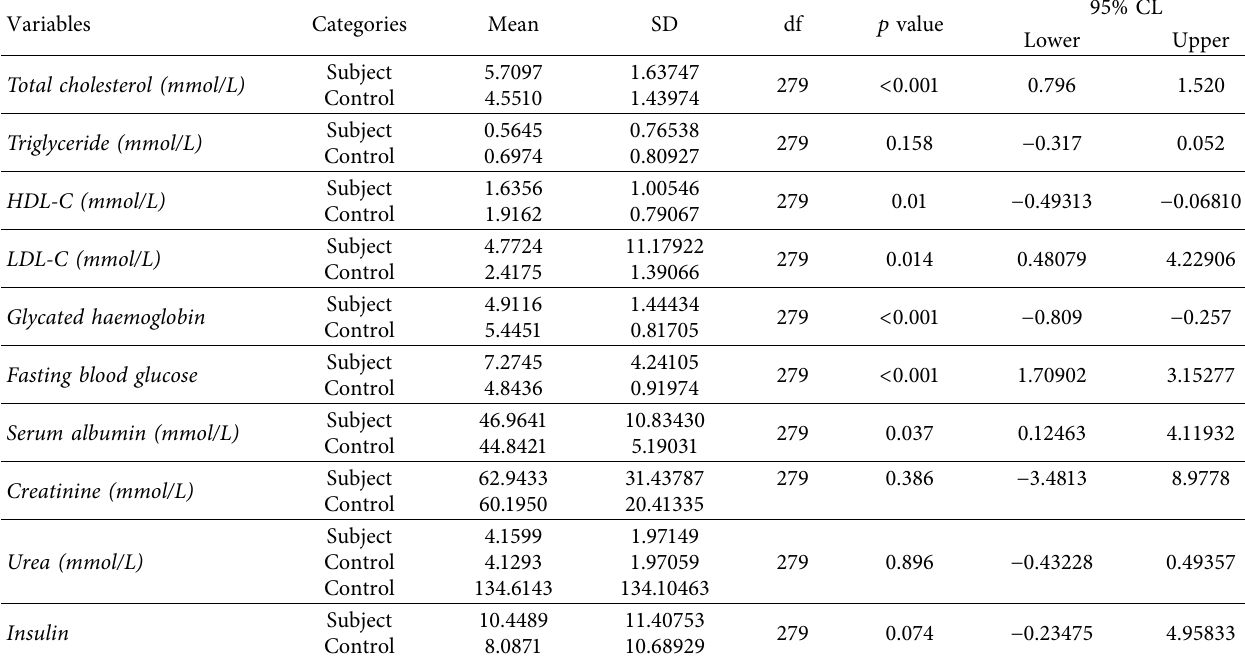
Table 5: Biochemical parameters of diabetics and nondiabetics